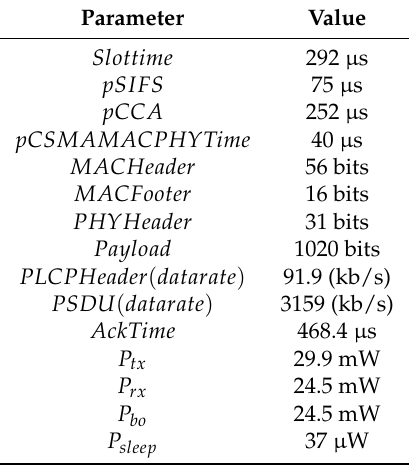
Table 3. UWB PHY-dependent MAC sublayer